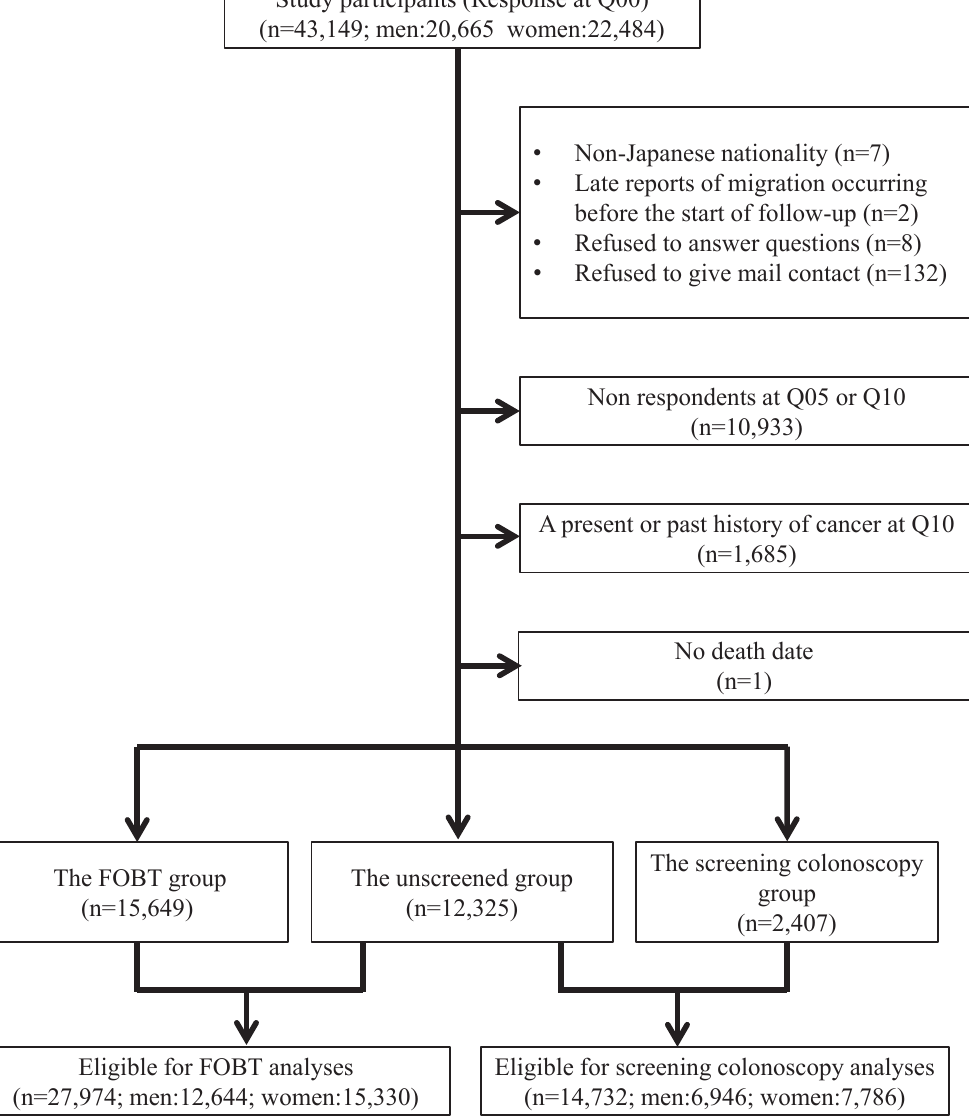
Figure 1. Subject fl owchart. FOBT, fecal occult blood